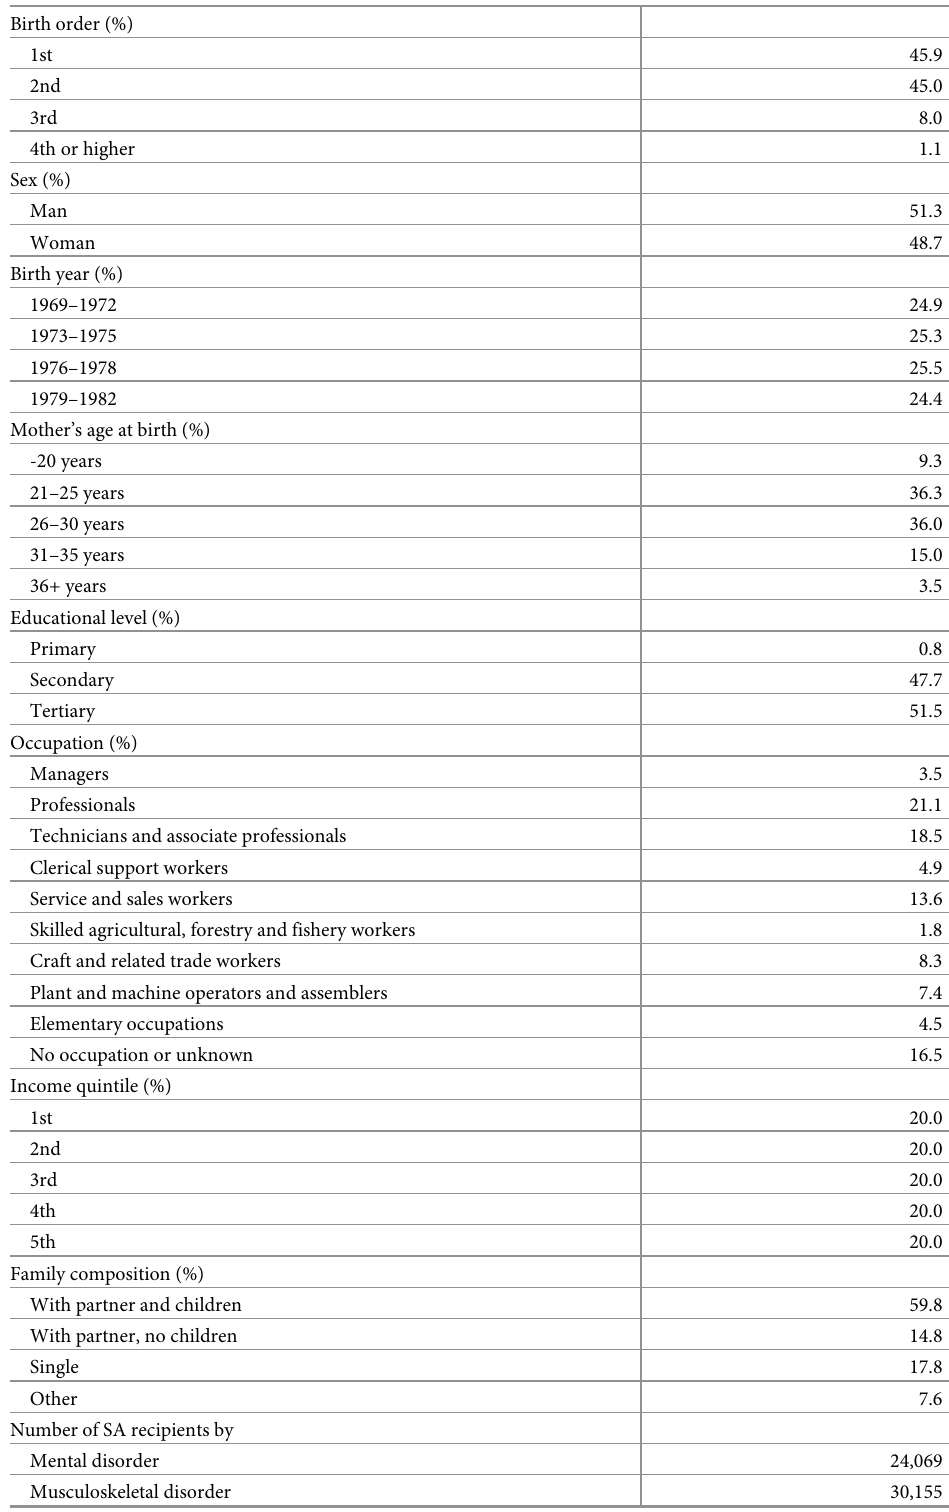
Table 1. Descriptive statistics of the study